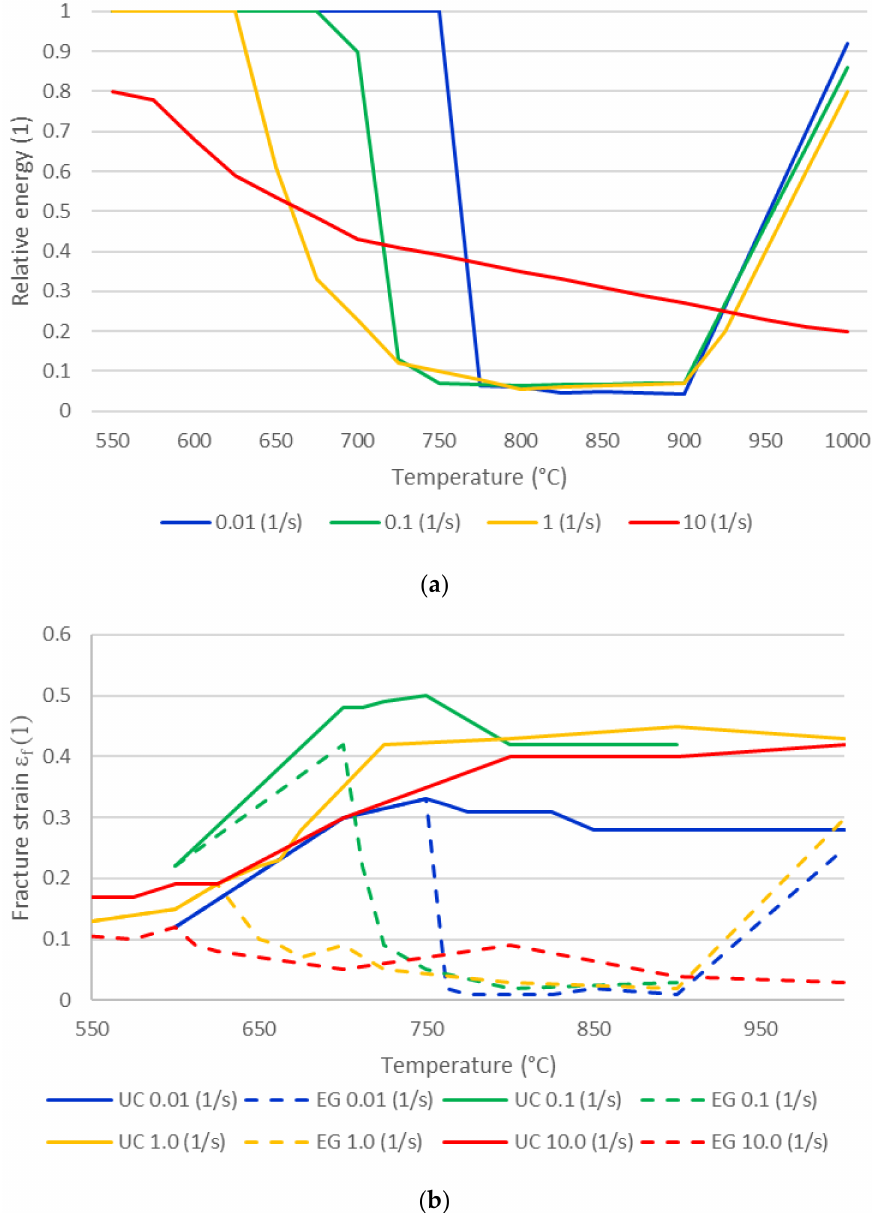
Figure 5. ( a ) Relative fracture energy between EG/UC and ( b ) fracture strain for all tested strain rates of EG/UC